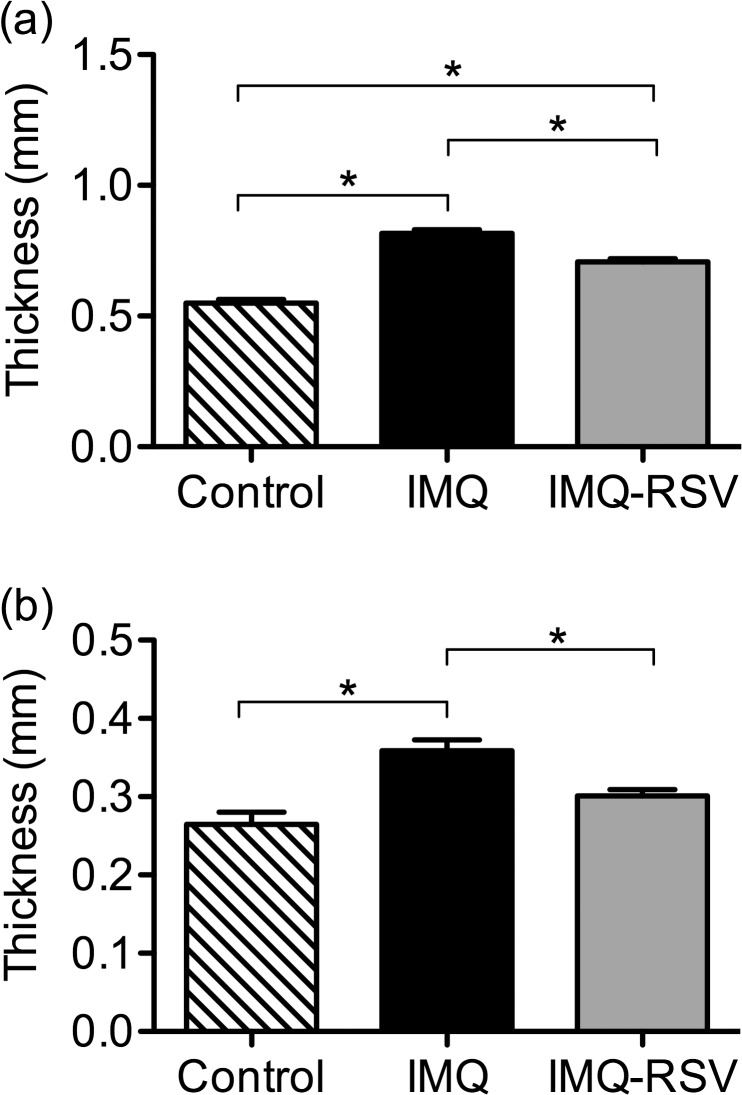
Calliper measurement of skin thickness.The right ear fold and the skinfold on the backs of the mice were measured to quantify the thickening of the skin caused by Imiquimod treatment. (a) Skinfold thickness on the backs of the mice. (b) Right ear fold thickness. Columns represent group means ±SEM of skin/ear fold measurements day 7 ((n = 8, n = 10, n = 10 for controls, IMQ, IMQ-RSV respectively). Clamped bar with * above indicates the pair of column means are significantly different (p<0.05).